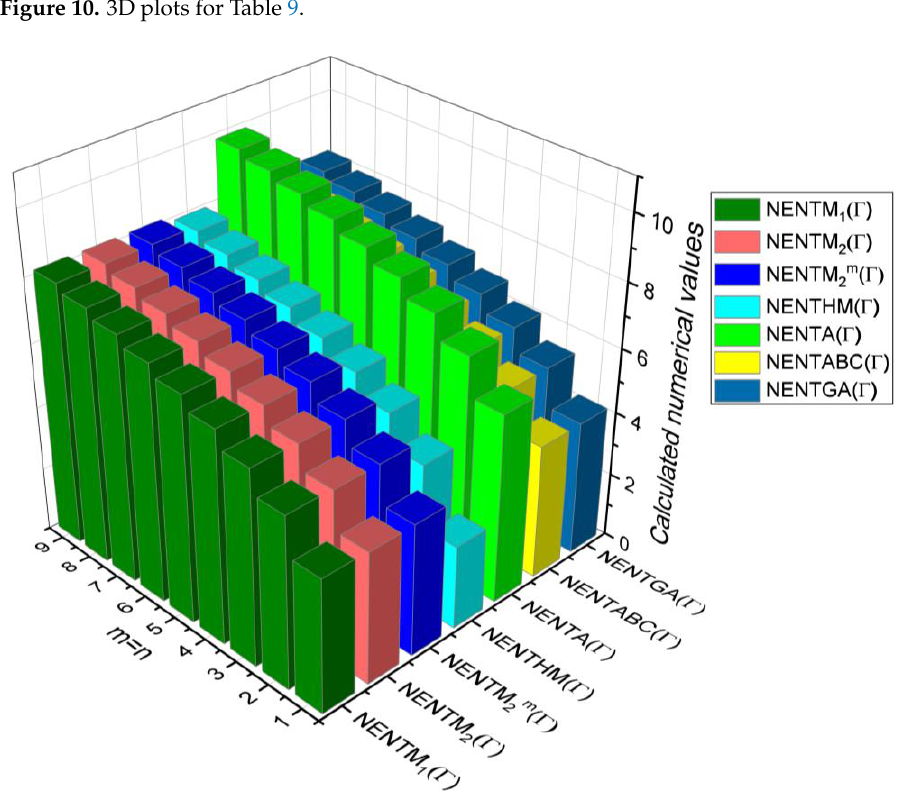
Figure 11. 3D plots for Table 10.